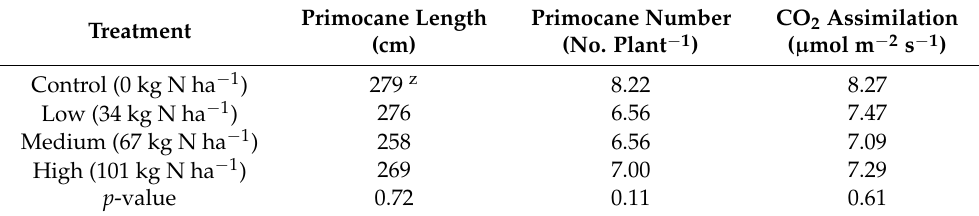
Table 4. Primocane length, primocane number, and primocane leaf CO 2 assimilation of “Meeker” floricane red raspberries fertilized with different nitrogen (N) fertilizer rates, 2020. Primocane Treatment